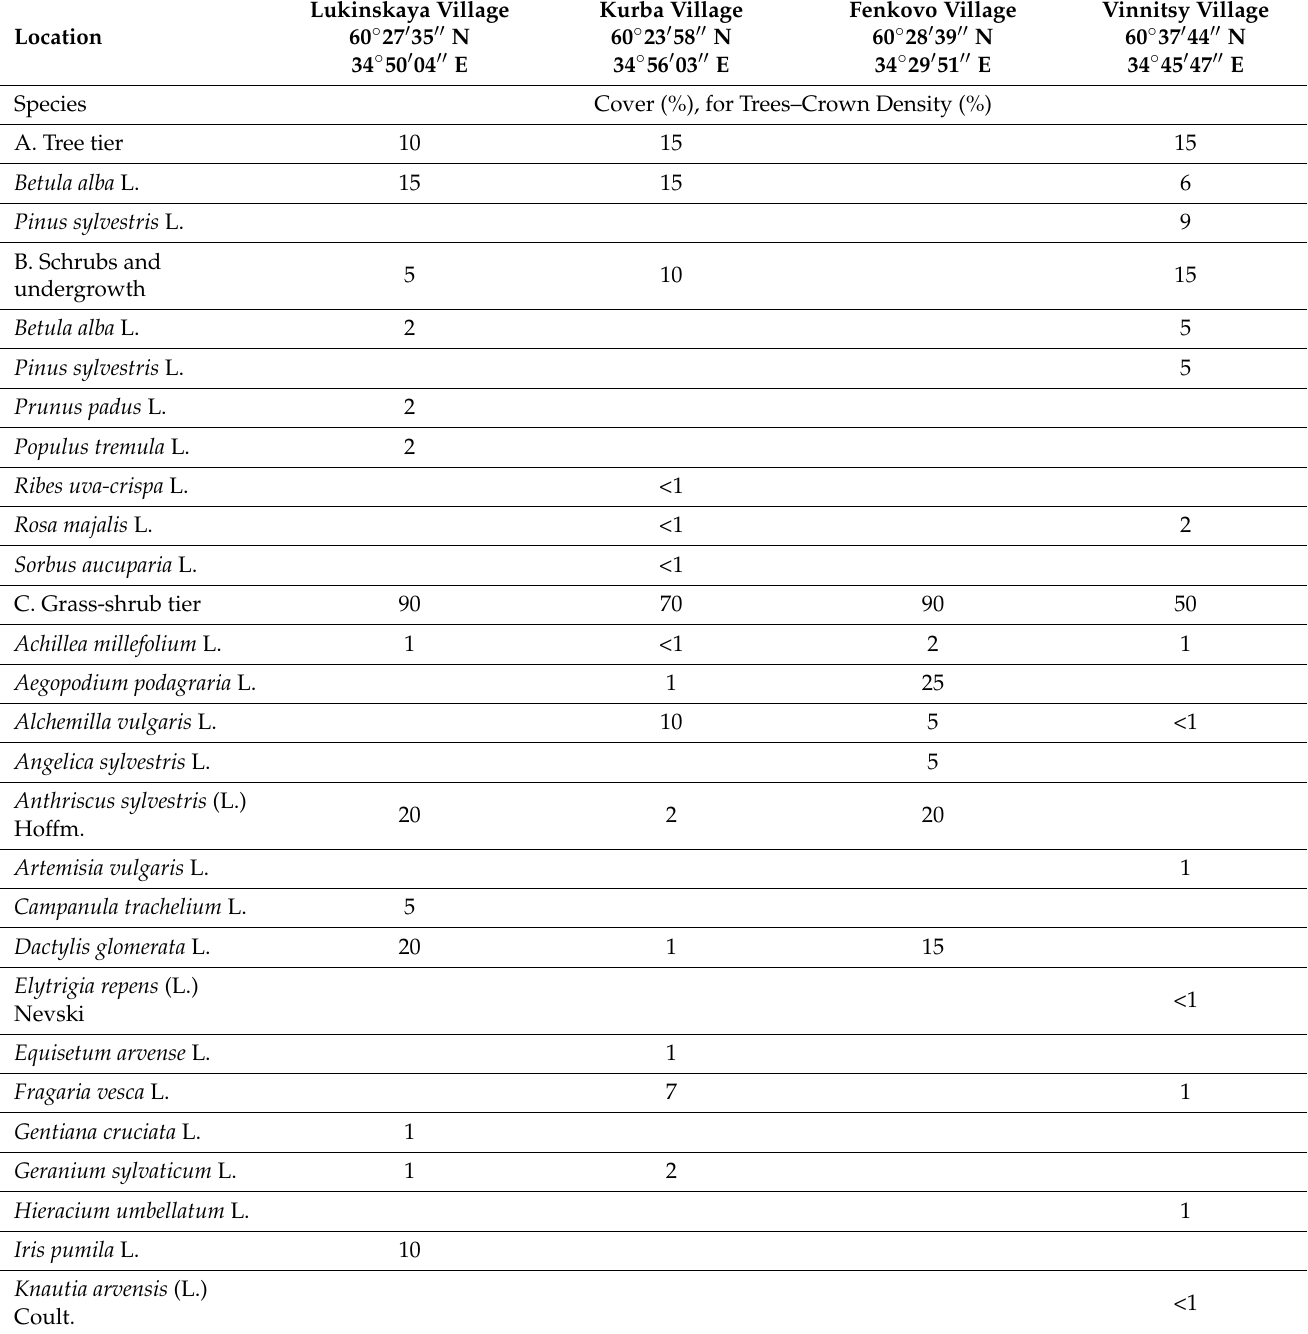
Table 2. Geobotanical descriptions of plant communities with L. polyphyllus